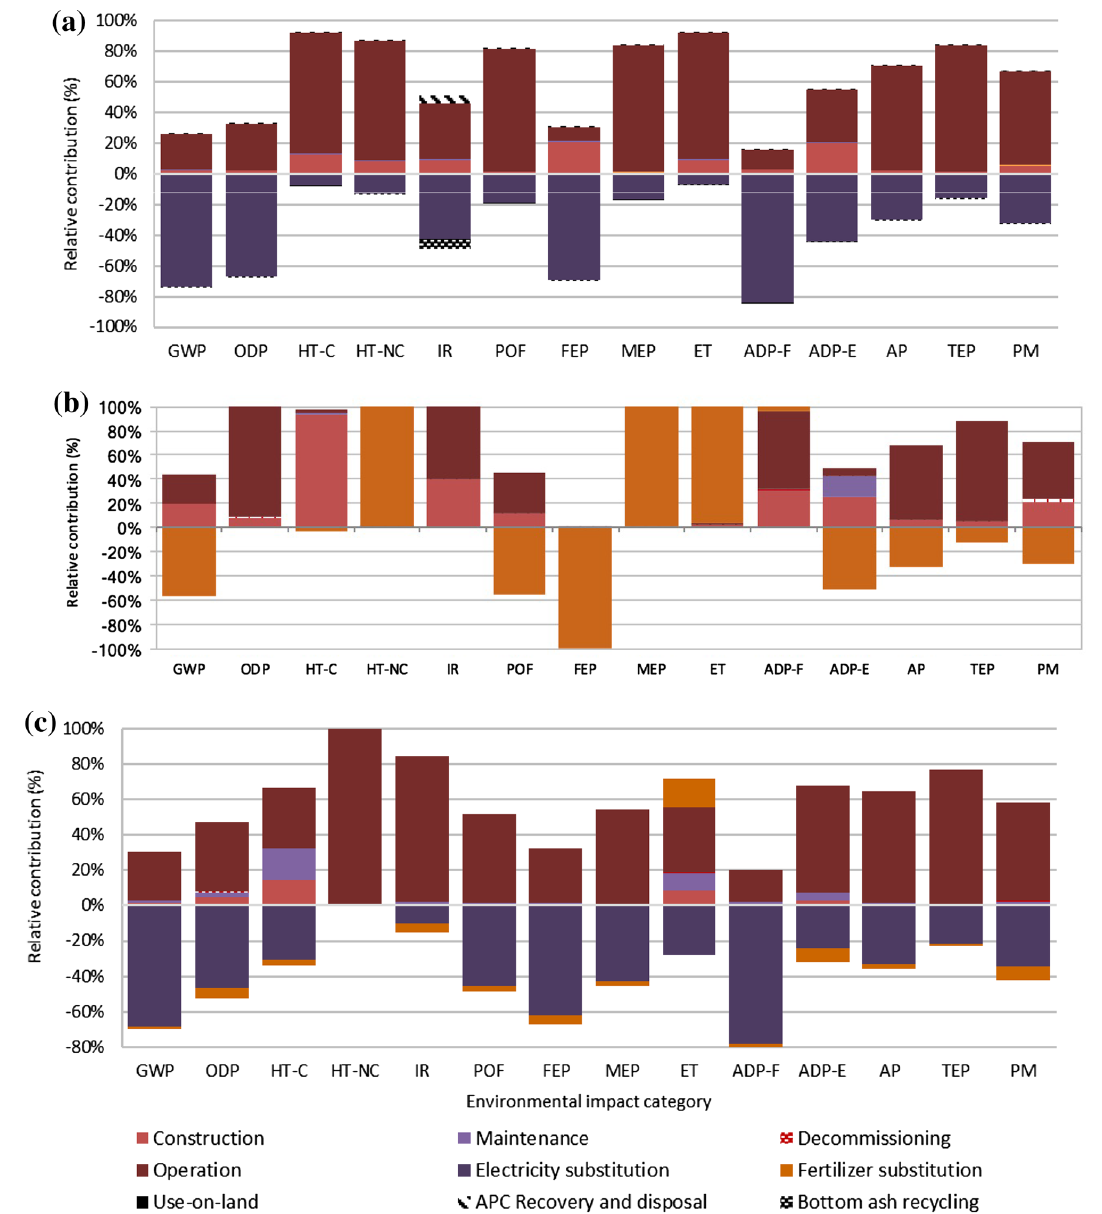
Fig. 4 Hotspot analysis of the analysis results for incineration ( a ), composting ( b ), and AD ( c ).Abbreviations are as follows: GWP global warming potential, ODP ozone depletion, HT - C emissions of carcinogens, HT - NC emissions of non-carcinogenic toxins, IR ionis- ing radiation, POF photochemical oxidant formation, FEP freshwater